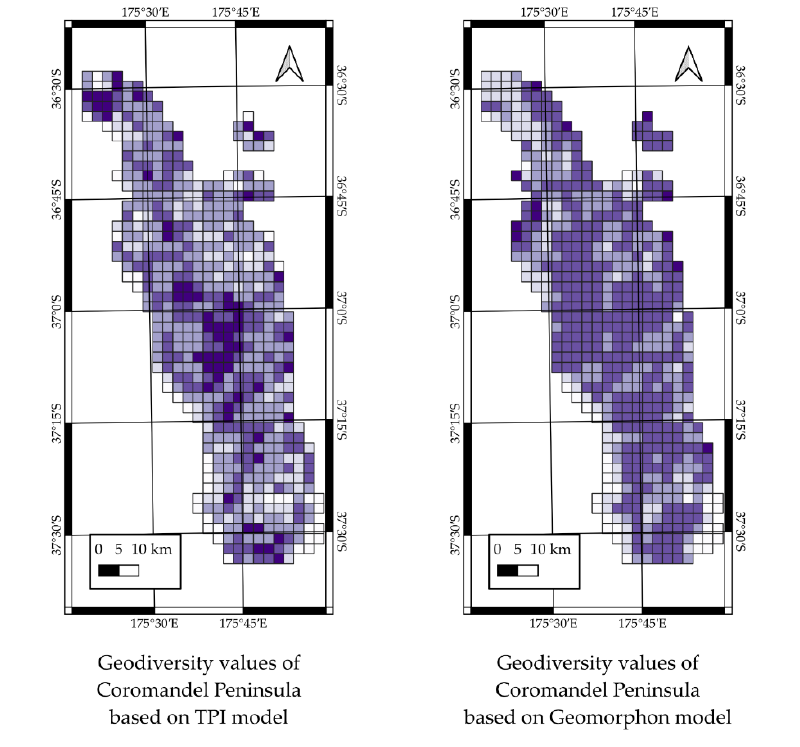
Figure 6. Geodiversity values of Coromandel Peninsula for geosite recognition, based on landform geomorphological models: TPI and Geomorphon. Natural breaks (Jenks) mode of evaluation.